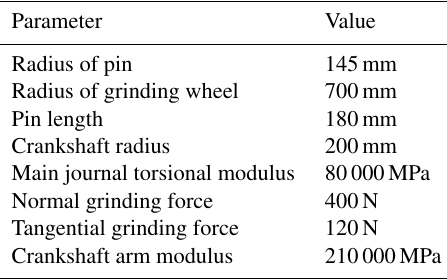
Table 1. Material properties of the crankshaft.